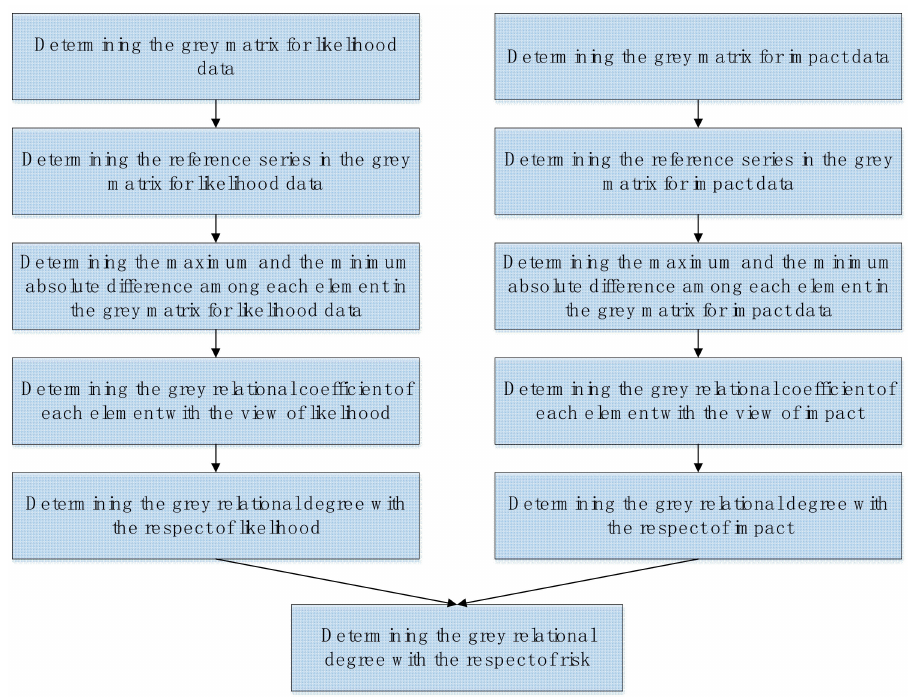
Figure 3. The procedure of GRA plus